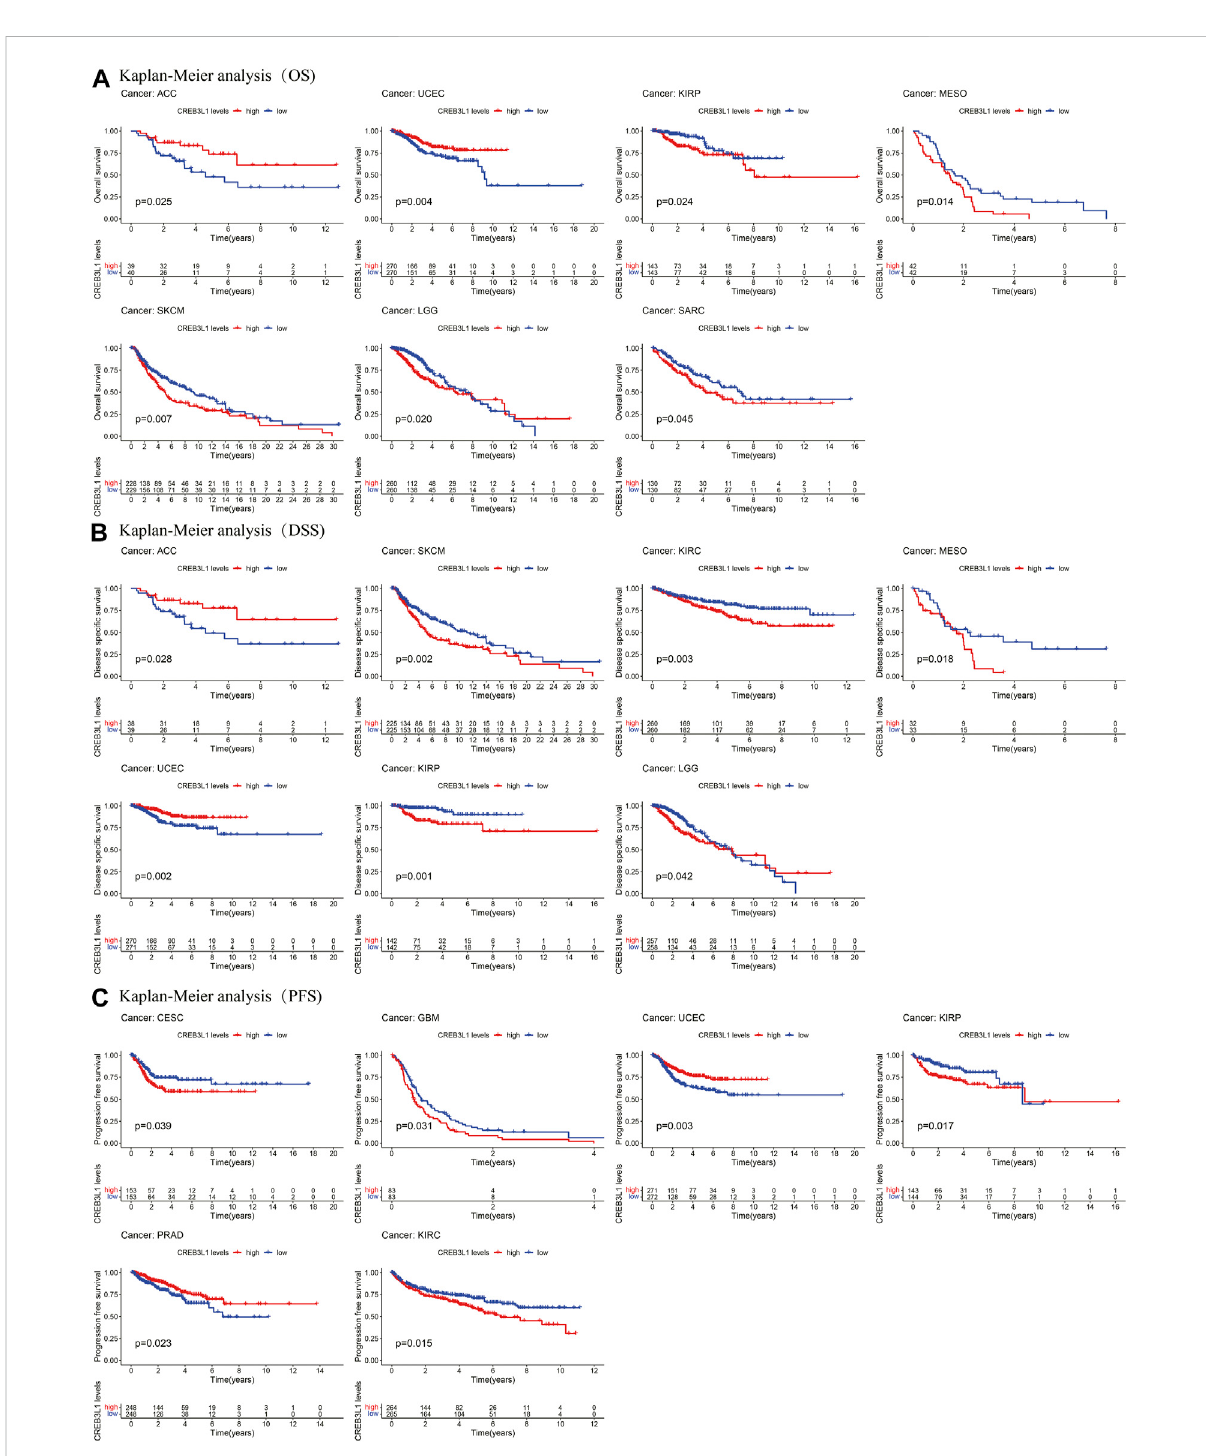
FIGURE 4 Kaplan-Meier survival curves of CREB3L1 in pan-cancer. (A) Kaplan – Meier analysis of the correlation between CREB3L1 expression and OS in 7cancertypes. (B) Kaplan – MeieranalysisofthecorrelationbetweenCREB3L1expressionandDSSin7cancertypes. (C) Kaplan – Meieranalysisofthe correlation between CREB3L1 expression and PFS in six cancer